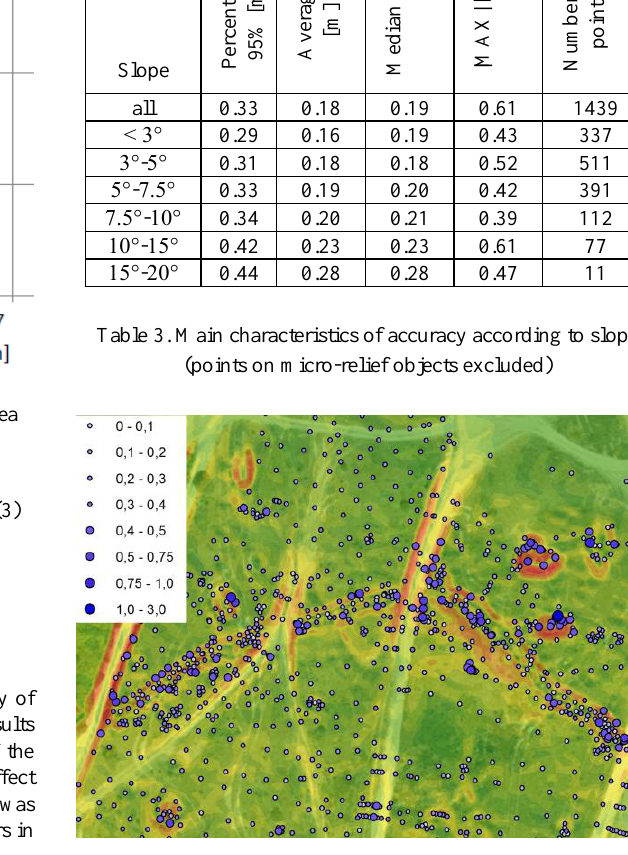
Figure 7. Visualization of deviations on top of the slope